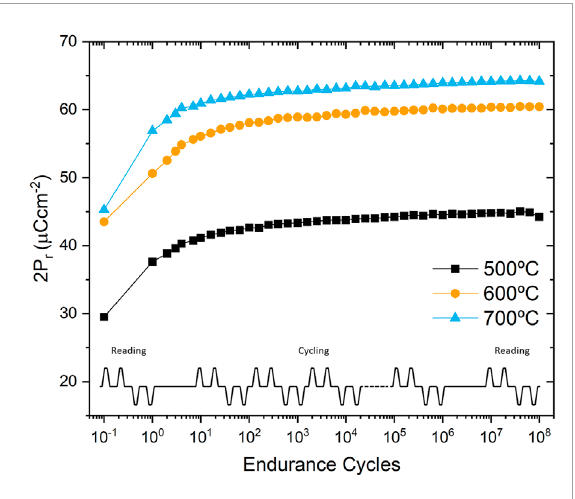
FIGURE 3 Endurance tests of the different HZO capacitors performed using trapezoidal PUND pulses with an amplitude 4 V and a frequency of 111 kHz frequency (i.e., t r = t f = 1.5 µs, t h = 1.5